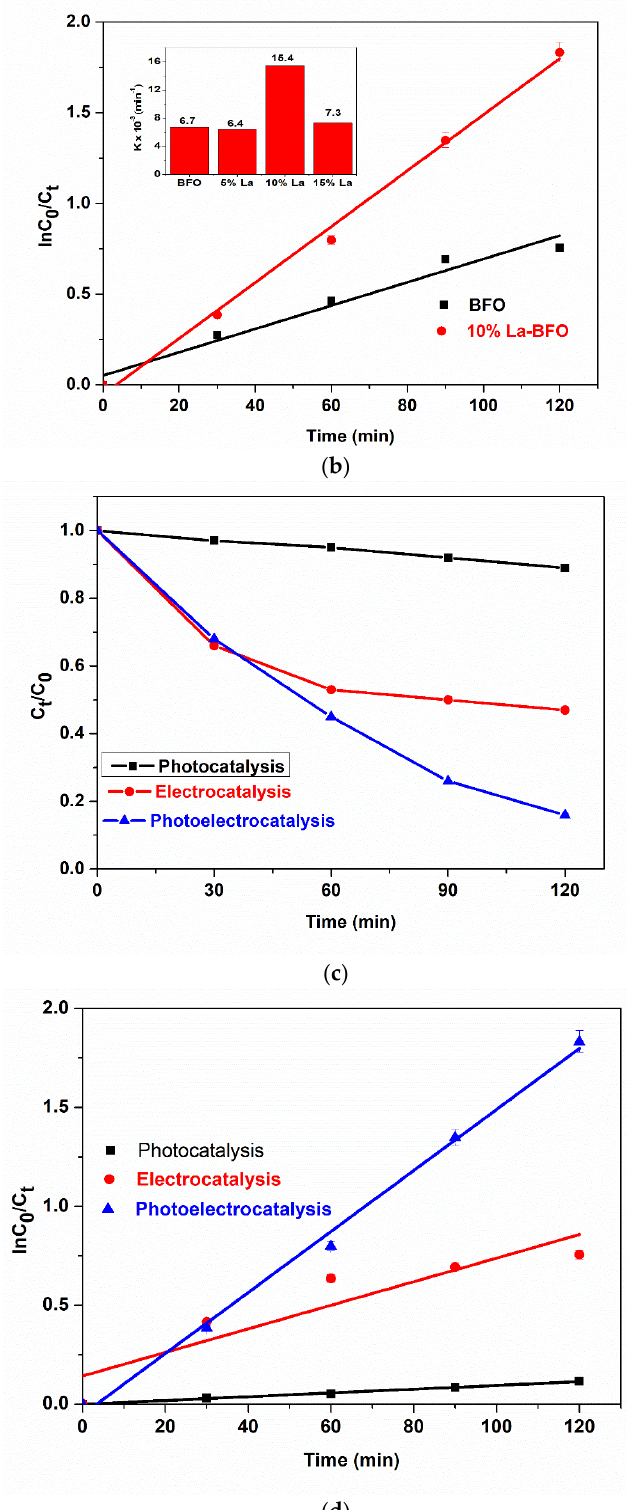
Figure 4. ( a ) Photoelectrocatalytic degradation of Orange II using BFO and 10% La-BFO; ( b ) kinetic plots for degradation of Orange II; ( c ) PC, EC and PEC degradation of Orange II using 10% La-BFO; ( d ) kinetic plot of PC, EC, and PEC (5 ppm; 2 V; pH